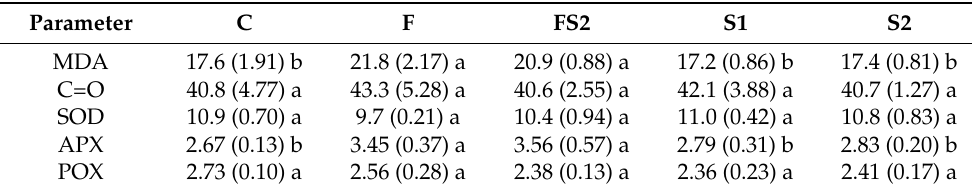
Table 5. Parameters of oxidative stress in bean leaves cultivated in: control soil (C—without EAF slag or NPK fertilizer), soil enriched with synthetic NPK fertilizer (F), soil enriched with a combination of 2% EAF slag and NPK fertilizer (FS2) and with EAF slag (S1—1%, S2—2% level).